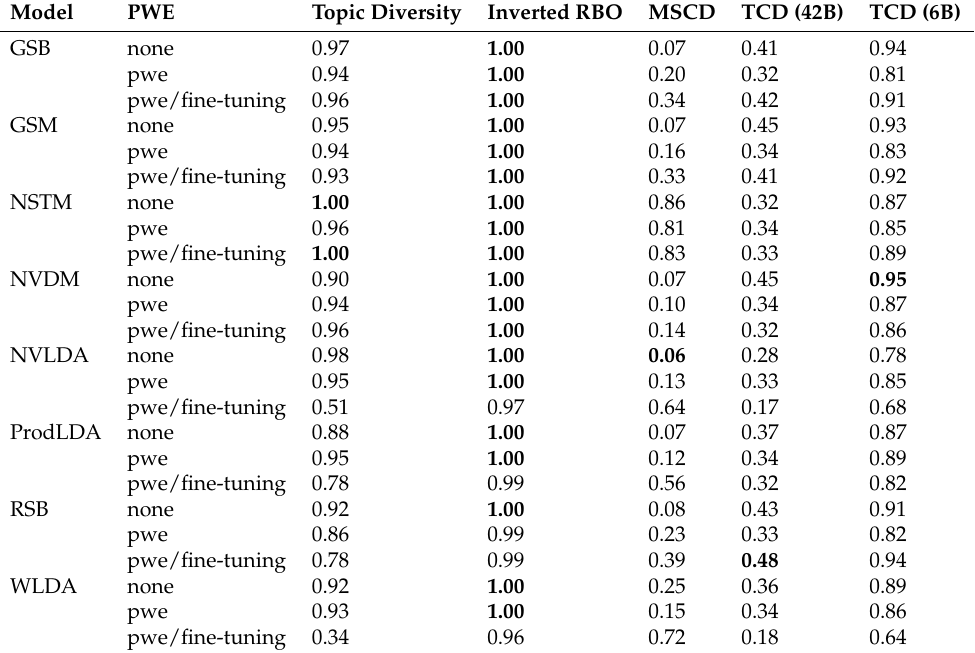
Table 20. Topic Diversity on SearchSnippets.